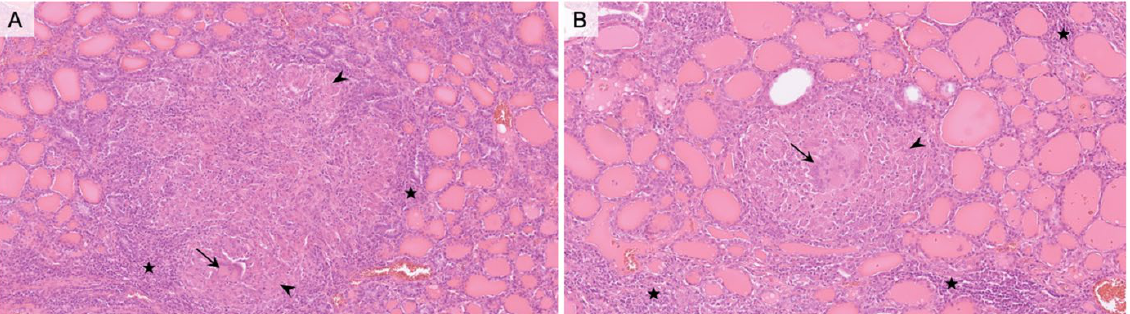
Figure 2. ( A ) 100× and ( B ) 200× hematoxylin- and eosin-stained sections of the thyroid lobectomy showing multiple scattered non-necrotizing epithelioid granulomas located in the interstitial tissue, with Langhans giant cells ( arrows ), epithelioid histiocytes ( stars ), and peripheral lymphocytic infiltrate ( arrowheads ). Our patient’s histopathological result from the thyroid specimen showed no signs of neoplasia. Non-necrotizing epithelioid granulomas were identified both in the thyroid specimen and in the left hilar lymph node, suggesting systemic sarcoidosis with involvement of the thyroid gland. The presence of non-necrotizing epithelioid granulomas is the pathologic hallmark feature of sarcoidosis. However, non-necrotizing granulomas are not specific for sarcoidosis and should be differentiated from other causes of granulomas such as tuberculosis and De Quervain’s Thyroiditis, but the latter was not suspected based on the clinical and biological data. Additionally, granulomas in De Quervain’s thyroiditis are typically found around the follicles, and giant cells surround a core of colloid, unlike sarcoid granulomas [6]. Tuberculosis was otherwise ruled out based on the lack of risk of exposure to the disease and the negative tuberculin test.